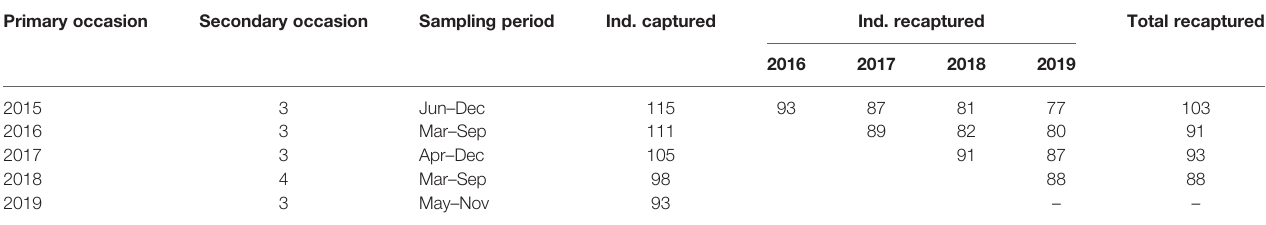
TABLE 2 | Data summary and sampling structure of the robust design